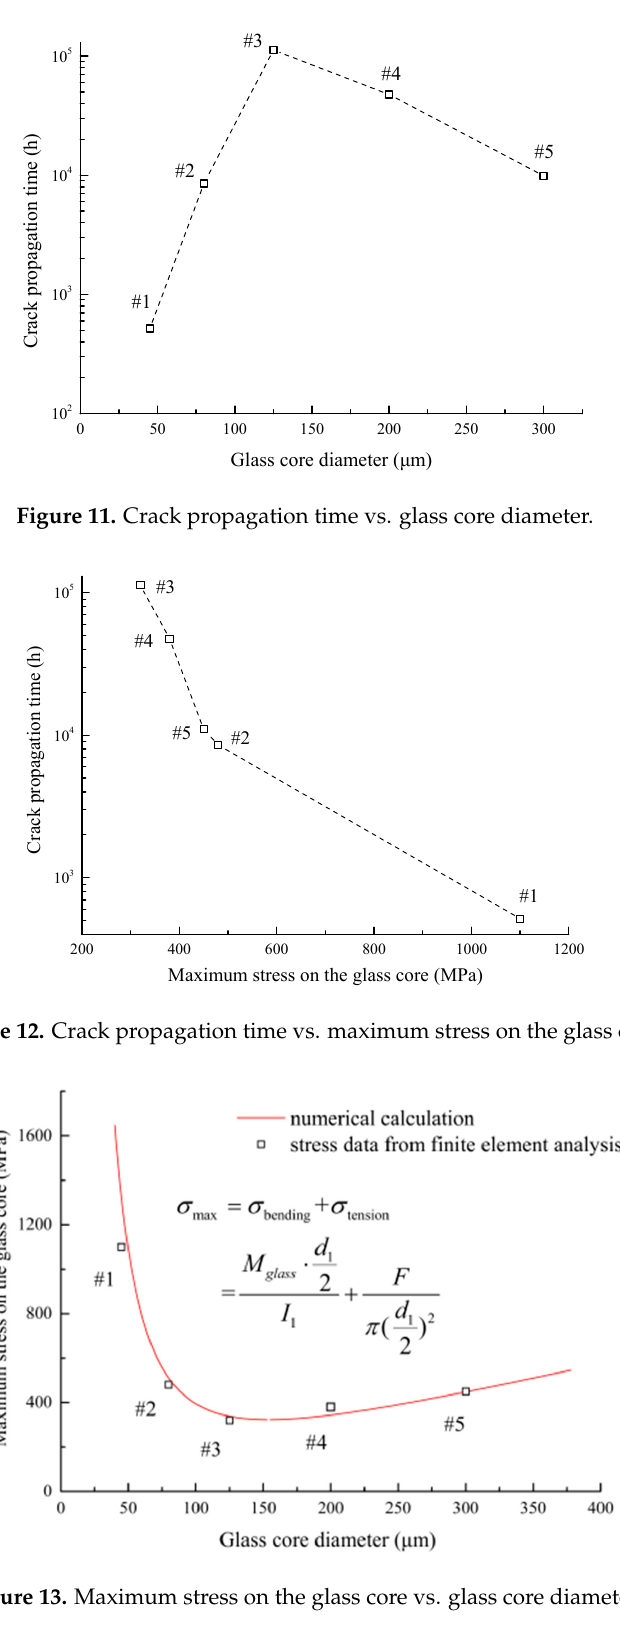
Figure 13. Maximum stress on the glass core vs. glass core